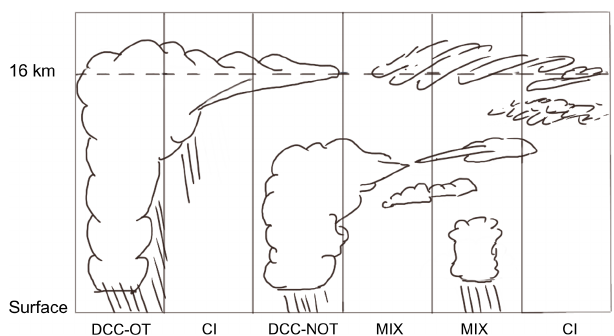
Figure 2. A schematic of the TTL cloud categories (see definitions in Sect.